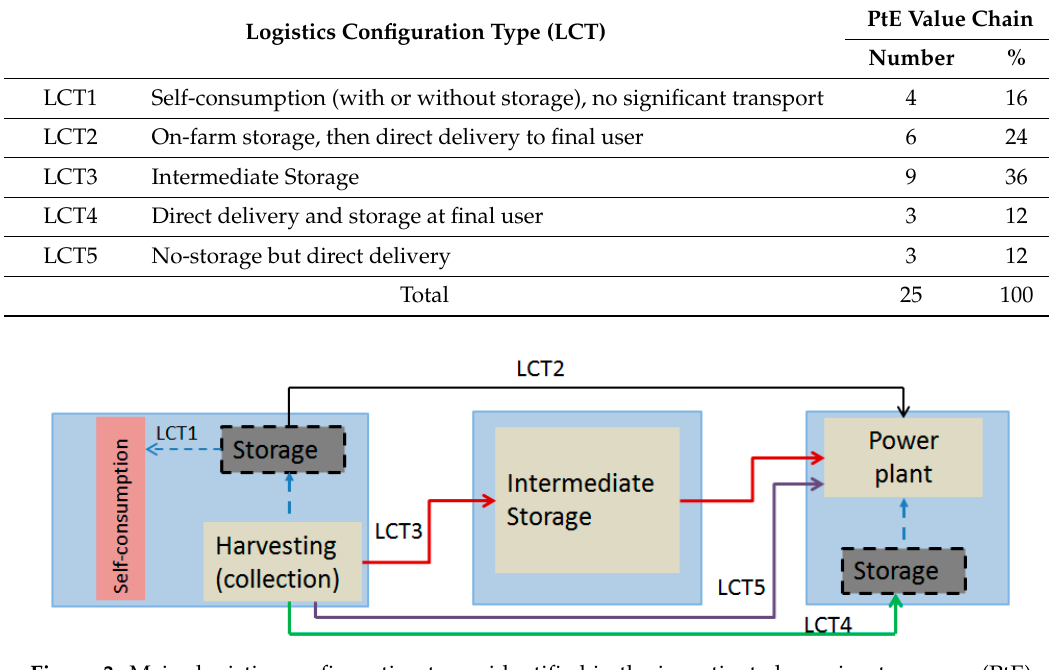
Figure 3. Major logistics configuration types identified in the investigated pruning-to-energy (PtE) chains (source: authors own illustration). chains (source: authors own